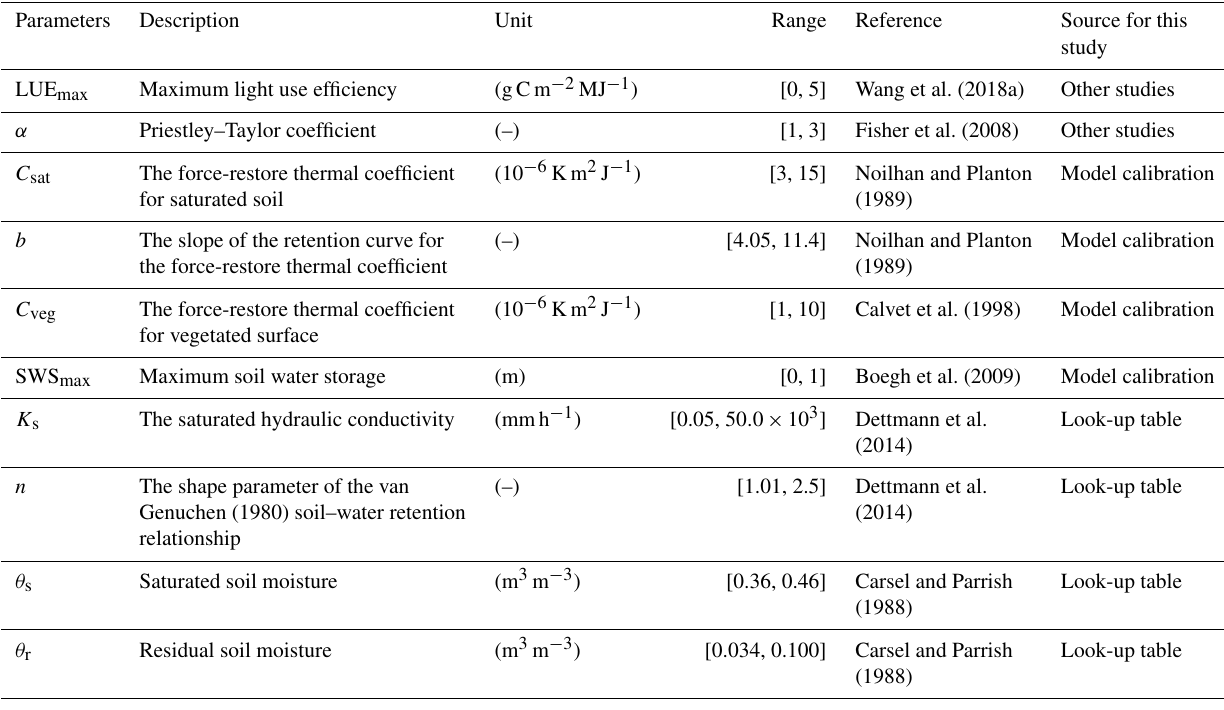
Table 2. Information on the model parameters of SVEN and their ranges for all soil or biome types.